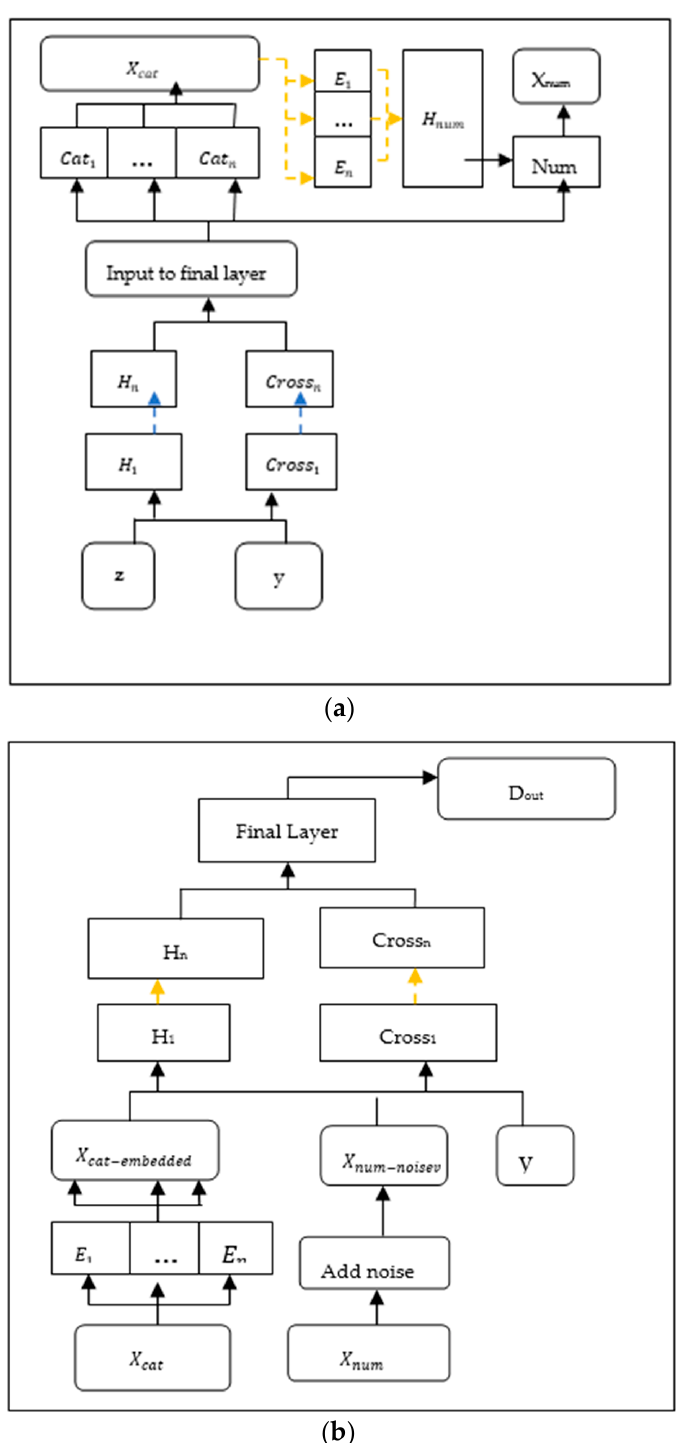
Figure 6. ( a ) Structure of the Generator network of WGANGP. ( b ) Structure of the Discriminator network of WGANGP.